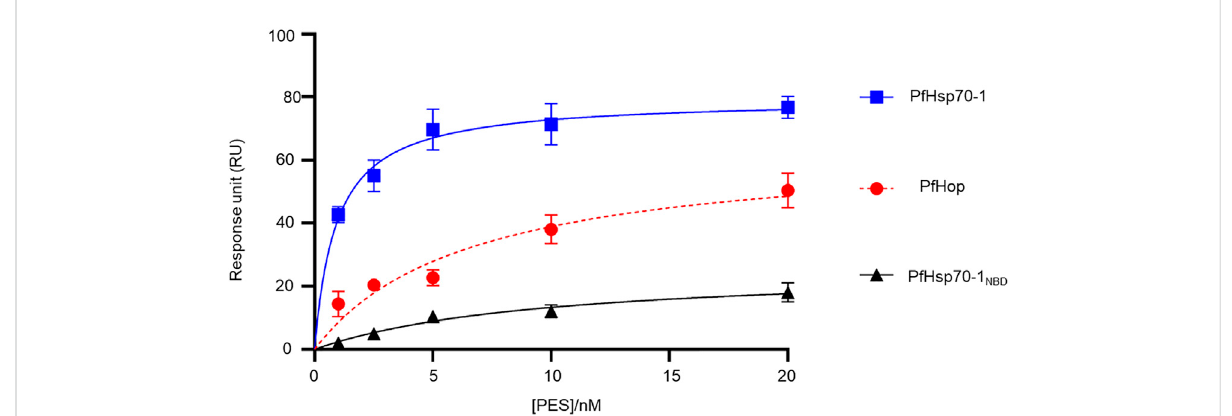
FIGURE 4 PES directly binds to both PfHsp70-1 and PfHop. As aligand, each ofPfHsp70-1 or PfHsp70-1 NBD or PfHop wasimmobilizedat aconcentration of 0.1 μ g/ml. The assay was conducted in the presence of variable levels of PES. The interaction between ligand and analyte was determined at equilibrium. Each curve is the average determined for three independent experiments, each performed in triplicate. The error bars are indicated as standard error about the mean.